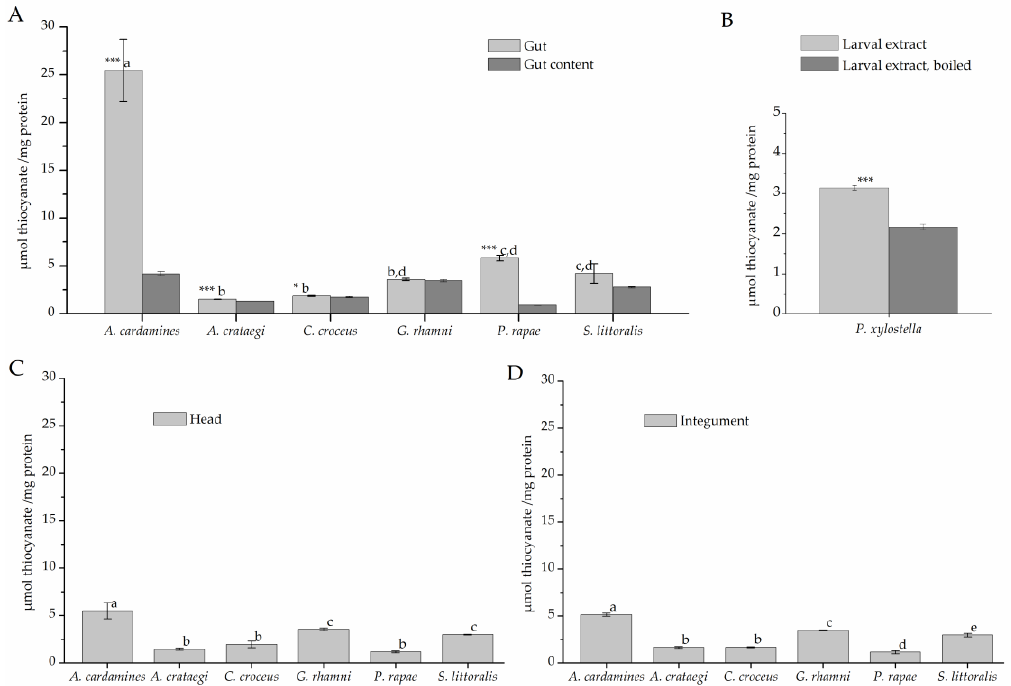
Figure 4. Rhodanese activity in lepidopteran larvae. Protein extracts were prepared from larval gut tissue ( A ), gut content ( A ), head ( C ), and integument ( D ) or from whole larvae ( B ) and incubated with 50 mM cyanide and 50 mM thiosulfate for 120 min. Thiocyanate formation was measured colorimetrically. Shown are means ± SD ( n = 3–5 larvae). Different letters above columns in A, C, and D indicate a significant difference ( p < 0.05, ANOVA with Tukey’s test) in a comparison of one sample type (gut tissue, head, integument) across species. Asterisks in A indicate a significant difference between gut tissue and gut content within a species (*, p < 0.05; ***, p < 0.001, t -test). The mean background level ( ± SD, n = 12) obtained with heat-denatured gut extract was 4,1 ± 2.9 µ mol/mg across all species used in A, C, and D. In B, asteriscs indicate a significant difference between larval extract and boiled control (***, p < 0.001, t -test).